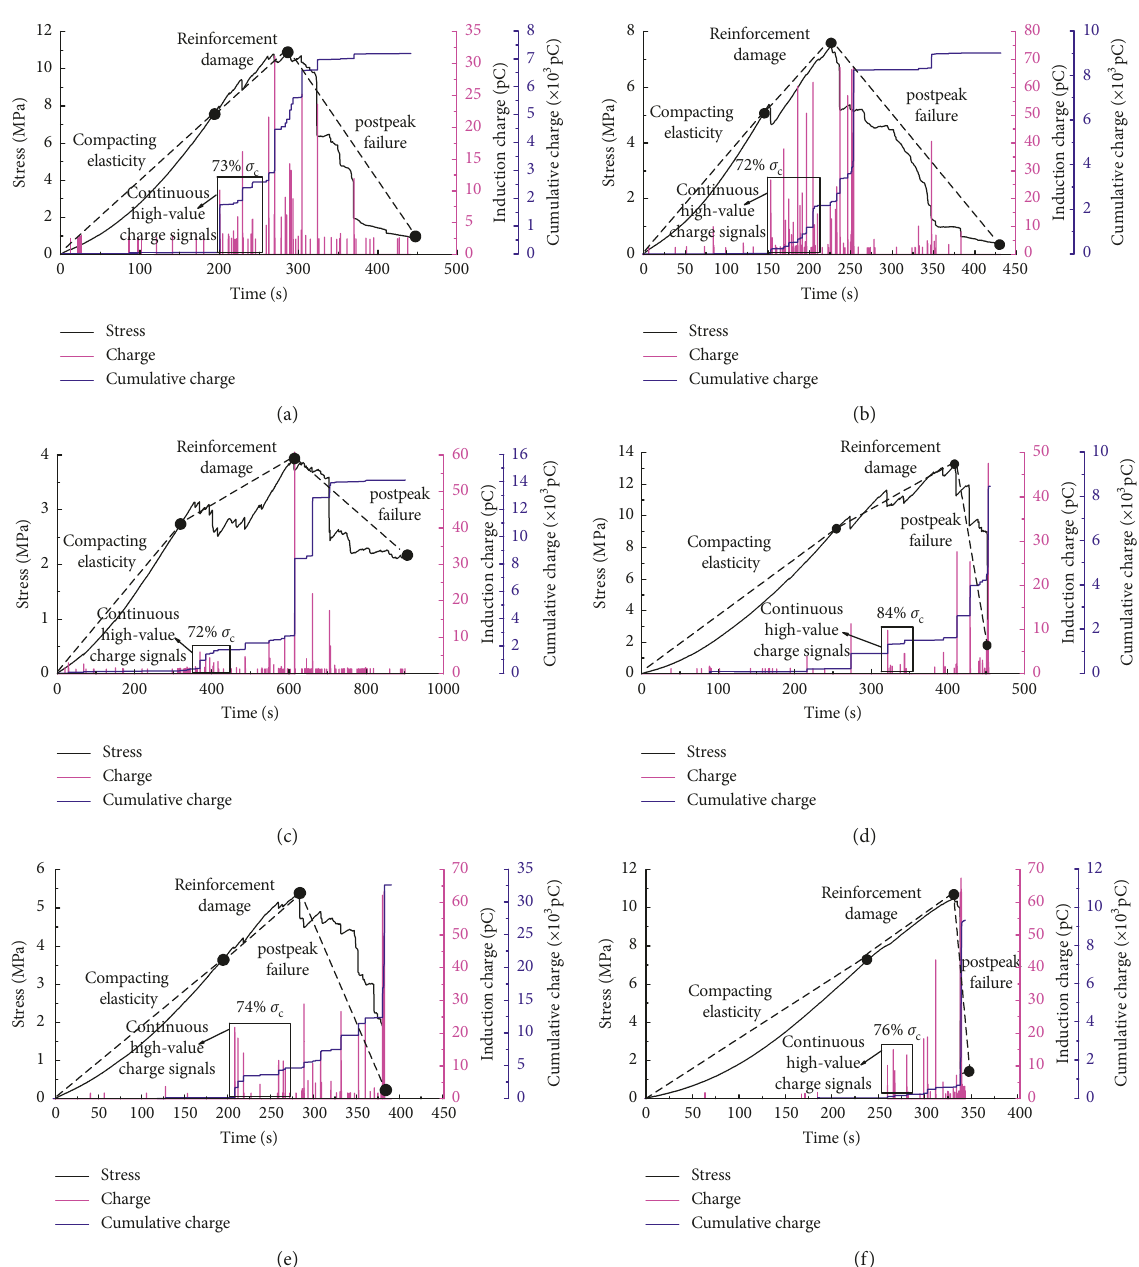
Figure 6: Charge-stress-time curve of coal samples under uniaxial compression. (a) Sample 1. (b) Sample 2. (c) Sample 3. (d) Sample 4. (e) Sample 5. (f) Sample